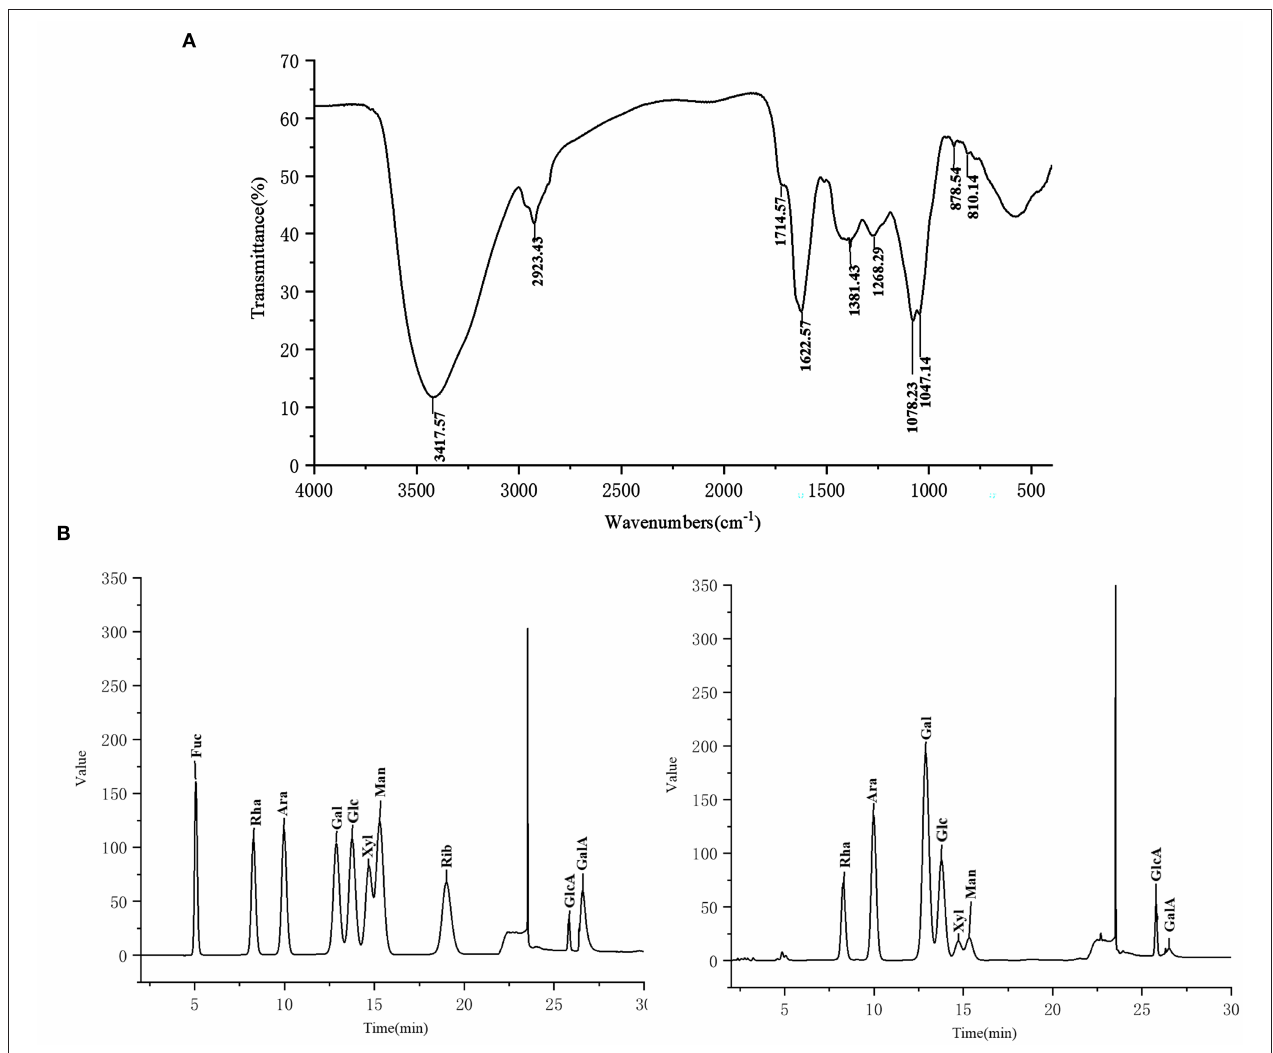
FIGURE 2 | The FT-IR spectra (A) and monosaccharide composition (B) of CCP.